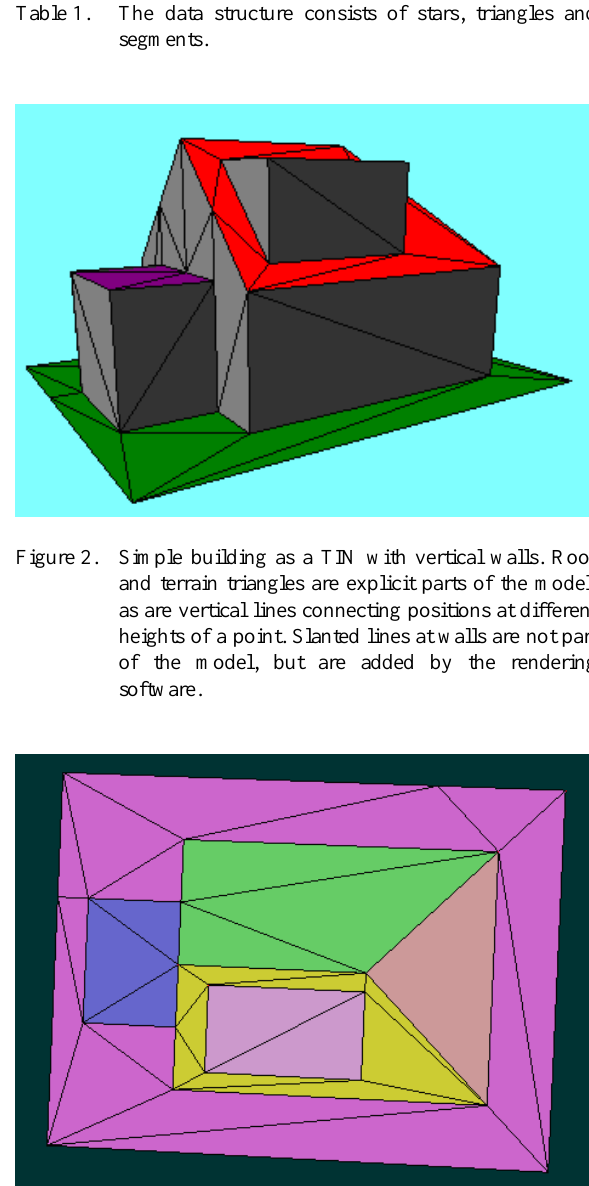
Figure 3. Orthogonal view of the building in Figure 2, showing coloured segments, triangles and x , y vertices that sometimes occur at different